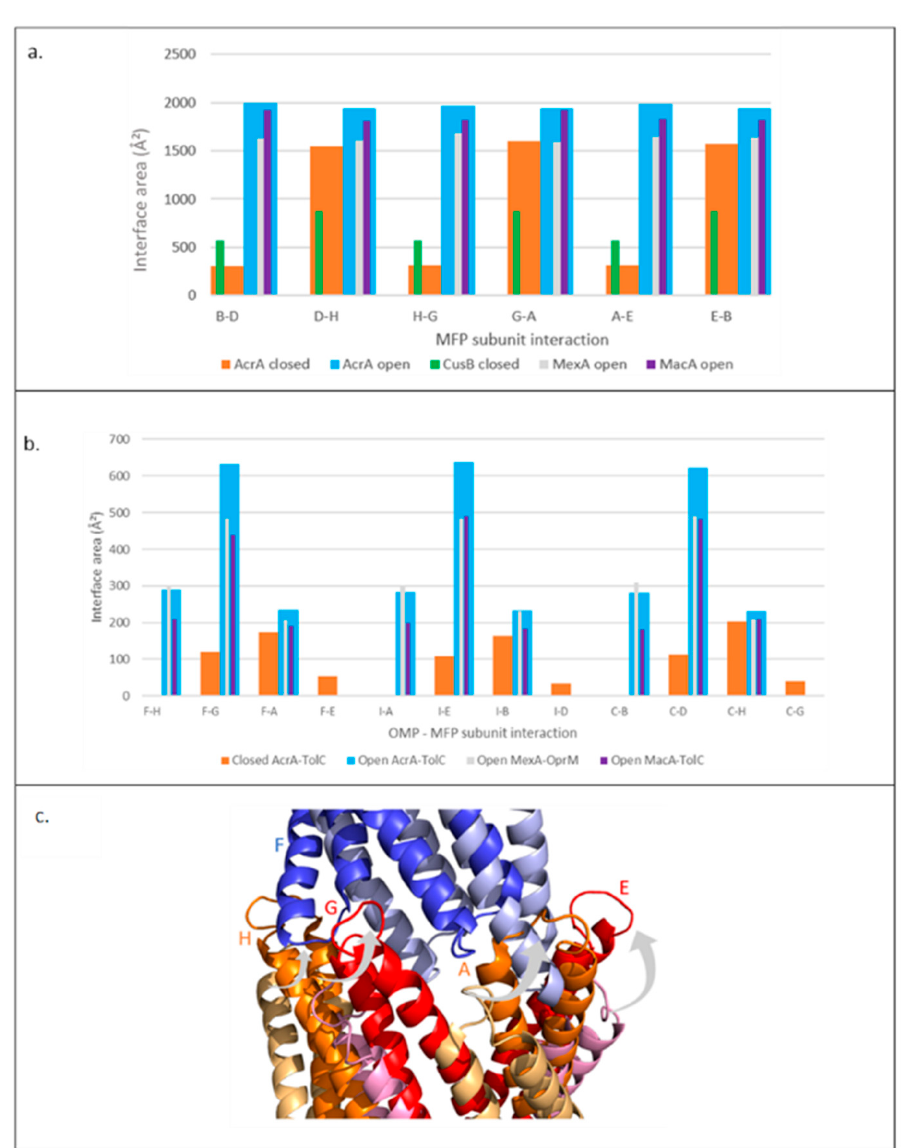
Figure 7. Trends in interface areas in other MFPs. ( a ) Interface area between subunits of different MFPs. ( b ) Tip-to-tip interface areas between OMP periplasmic helices and MFP HLH domains. OMP subunits: F, I, E. MFP subunits: H, G, A, E, B, D. ( c ) Aligned structures of AcrA-TolC tip-to-tip interaction. An individual TolC subunit is shown in the resting (light blue) and the transport (dark blue) state. Four AcrA subunits are shown in the resting (alternate pale yellow and pink) and the transport (alternate orange and red) state. Grey arrows show the direction of AcrA HLH twisting movement on pump activation. Results shown for Open MexAB-OprM (transport state) are from analysis of the 6TA6 PDB file; similar results were obtained for 6IOK and 6IOL as well (data not shown). Subunit numbering is based on AcrA 5NG5. MFP: Membrane Fusion Protein, OMP: Outer membrane